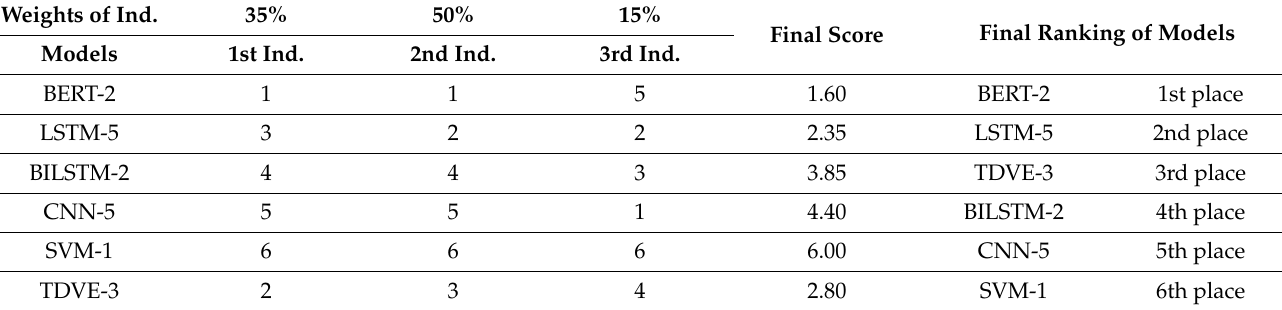
Table 4. Overall ranking of the models with weights per indicator. Table 4 . Overall ranking of the models with weights per indicator.